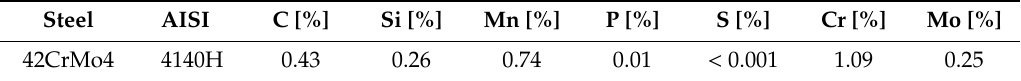
Table 1. Chemical composition in mass% of steel AISI 4140H (EN